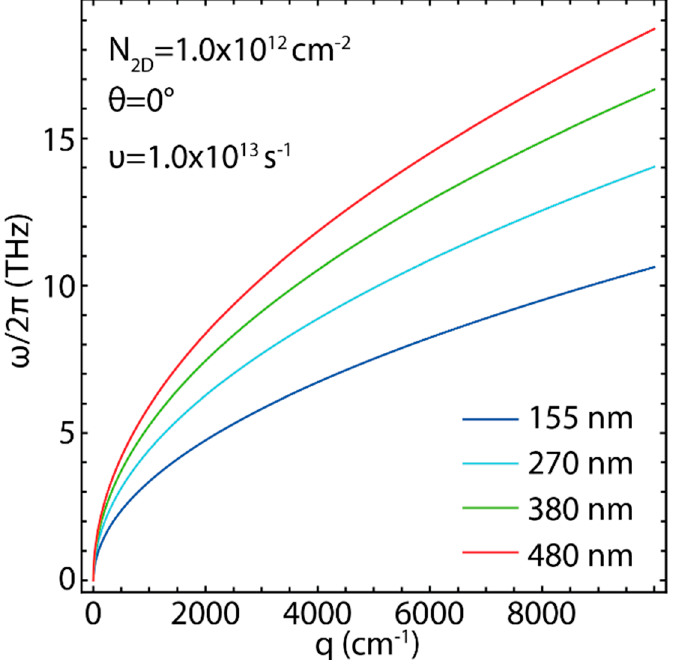
Figure 5. Plasmon frequency dispersion ( ω /2 π ) vs. wave vector ( q ), considering different ribbons widths (155, 270, 380, and 480 nm). The parameters of Equation (4) have been fixed as: N 2 D = 1.0 × 10 12 cm − 2 , θ = 0, v = 1.0 × 10 13 s − 1 , and v F = 0.829 × 10 6 m s − 1 .